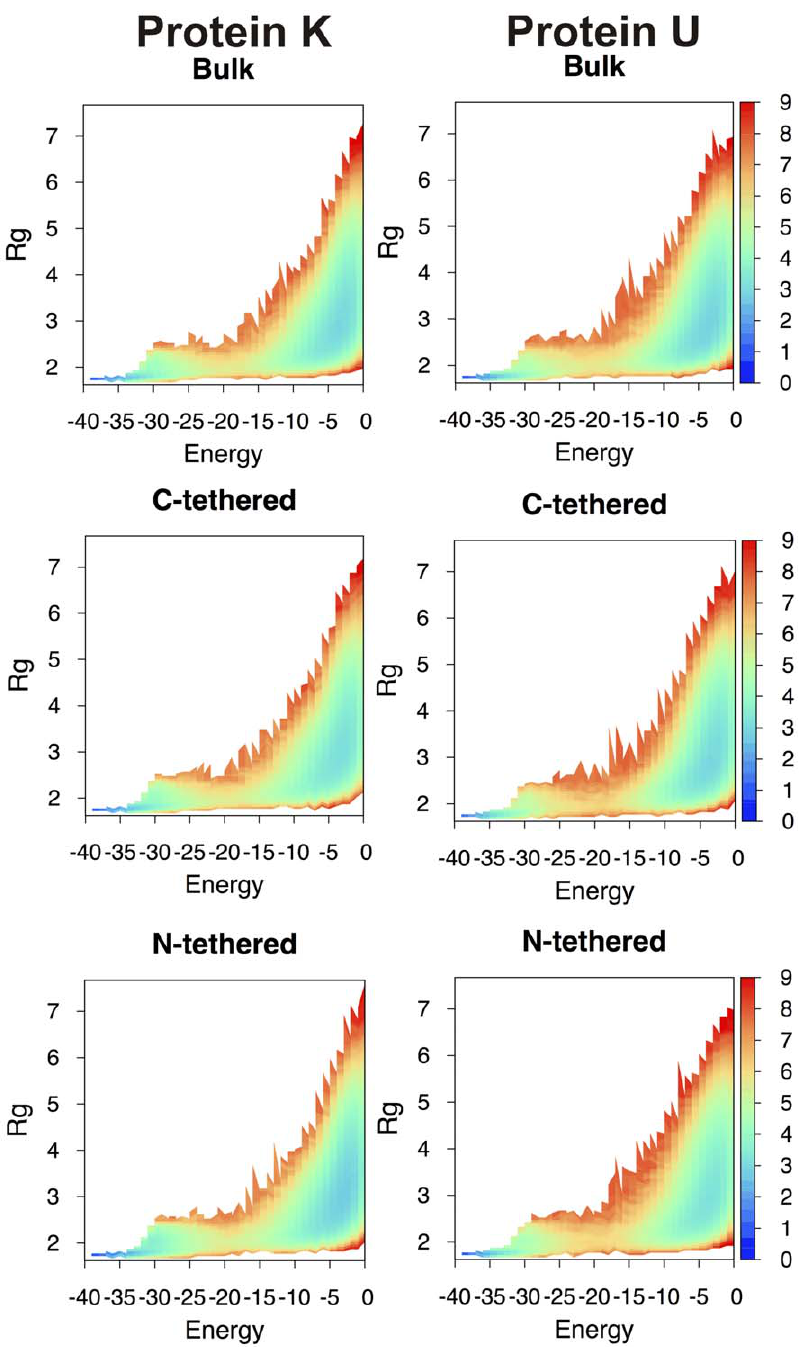
(left) and the unknotted protein (right) in the considered folding setups. Since the native state is unequivocally defined by a unique conformation it appears as one point in the free energy surface (instead of being represented by a native basin as in the case of off-lattice models).